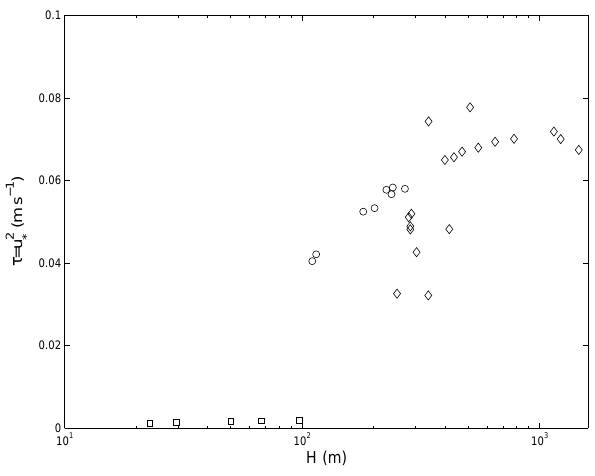
Fig. 2. The dependence of the turbulent surface stress, τ s = u 2 ∗ on the PBL depth H . Data and notation are as in Fig. 1.